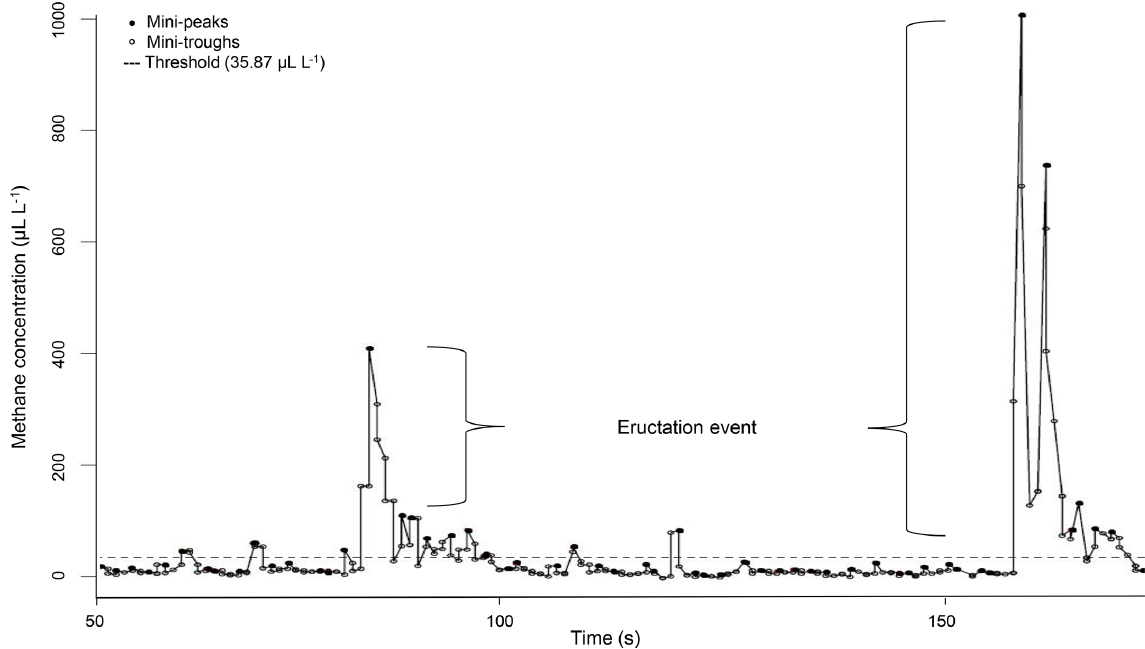
Figure 1. Example for a CH 4 measurement profile of one ewe recorded via laser methane detector (LMD) and corrected for background CH 4 . Values under the threshold describe CH 4 emissions during respiration and values above the threshold describe CH 4 emissions during